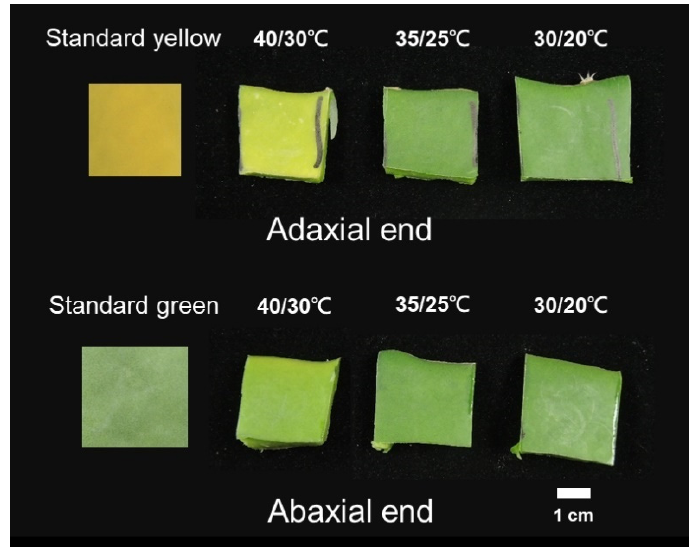
Figure 1. Shoot re-greening on the adaxial and abaxial ends of shoots in “Da Hong” pitaya at the end of the experiment under optimum temperature as control (OT, 30 °C/20 °C), moderately high temperature (MH, 35 °C/25 °C), and high temperature (HT, 40 °C/30 °C) treatments in 2017. Standard yellow and standard green were the shoot colors on the adaxial and abaxial ends, respectively, in all three groups before the experiments.